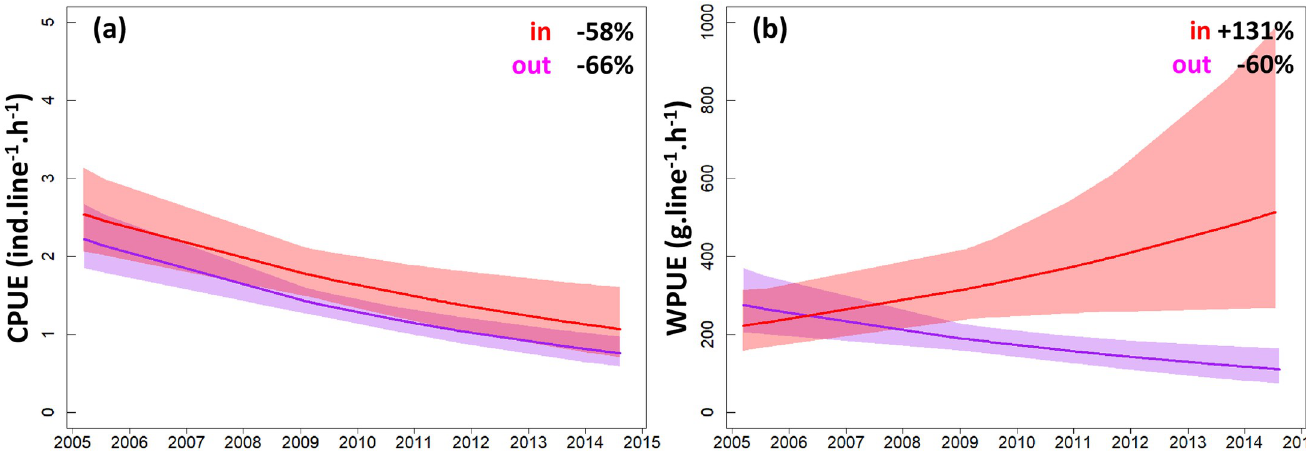
Fig 2. Trends in catch per unit effort (CPUE, a) and weight per unit effort (WPUE, b) of recreational fishermen fishing inside (in) and outside (out) the Cerb è re-Banyuls marine reserve. Curves represent mean trajectories estimated by generalized linear models and shadings indicate 95% confidence intervals. The percent changes in mean CPUE and WPUE between the beginning and the end of the study period are provided as text on the plots. See S4 Table for mean and confidence interval values. Refer to S5 Table for parameter estimates.